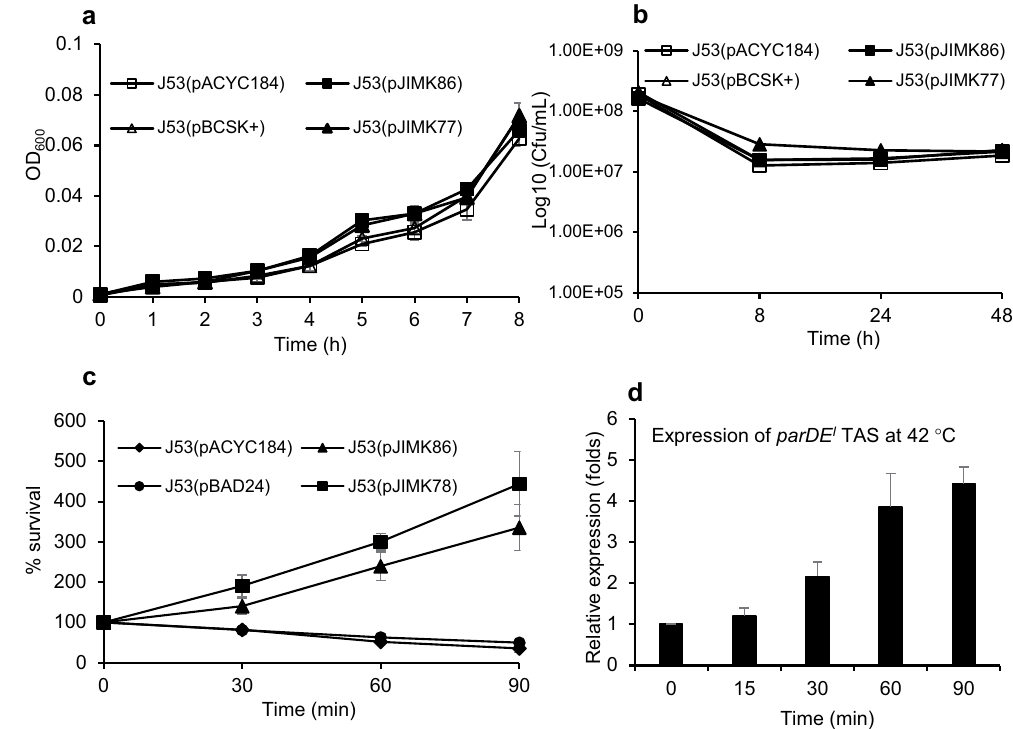
Figure 6. The effect of ParDE I on E. coli (J53) growth in stress conditions. E. coli with cloned ParDE I (pJIMK86) is not significantly different from the vector-only control in nutrient limitation ( a ) and nutrient starvation ( b ). A significant benefit is evident in E. coli J53(pJIMK86) and after activation of toxin from pJIMK78 (induction with 0.2% arabinose) for growth at 42 °C ( c ). Expression of ParDE I is also increased at 42 °C ( d ). Each experiment was repeated 3 times and mean values and standard deviations (error bars) are